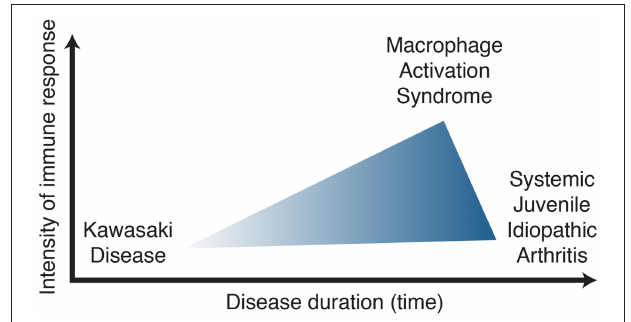
FIGURE 2 | Kawasaki disease, systemic juvenile idiopathic arthritis, macrophage activation syndrome spectrum of